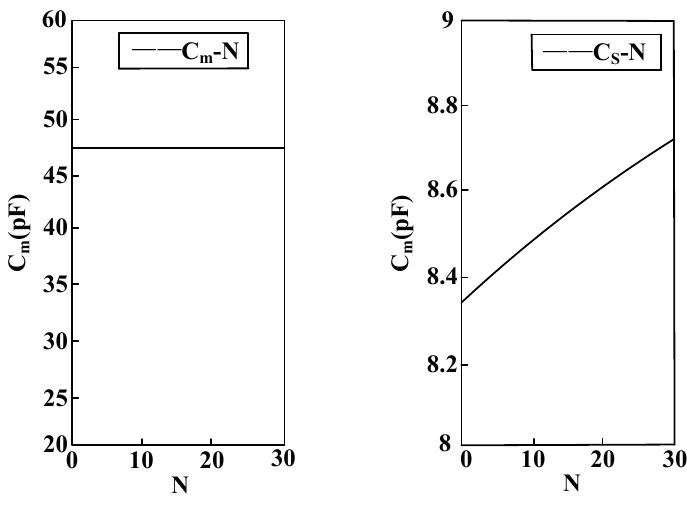
Figure 14. Curve of the relation between equivalent capacitance and number of